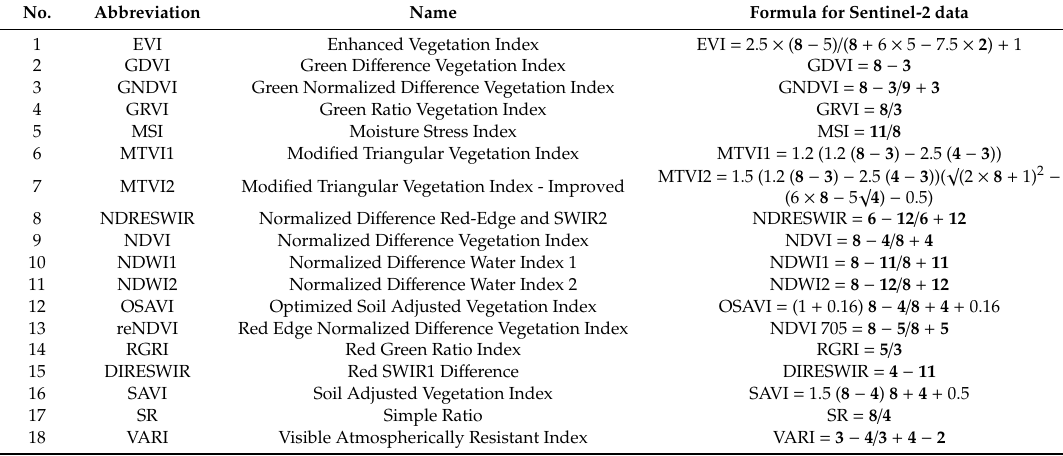
Table A1. Vegetation indices used in the study (bold numbers in formulas indicate individual Sentinel-2